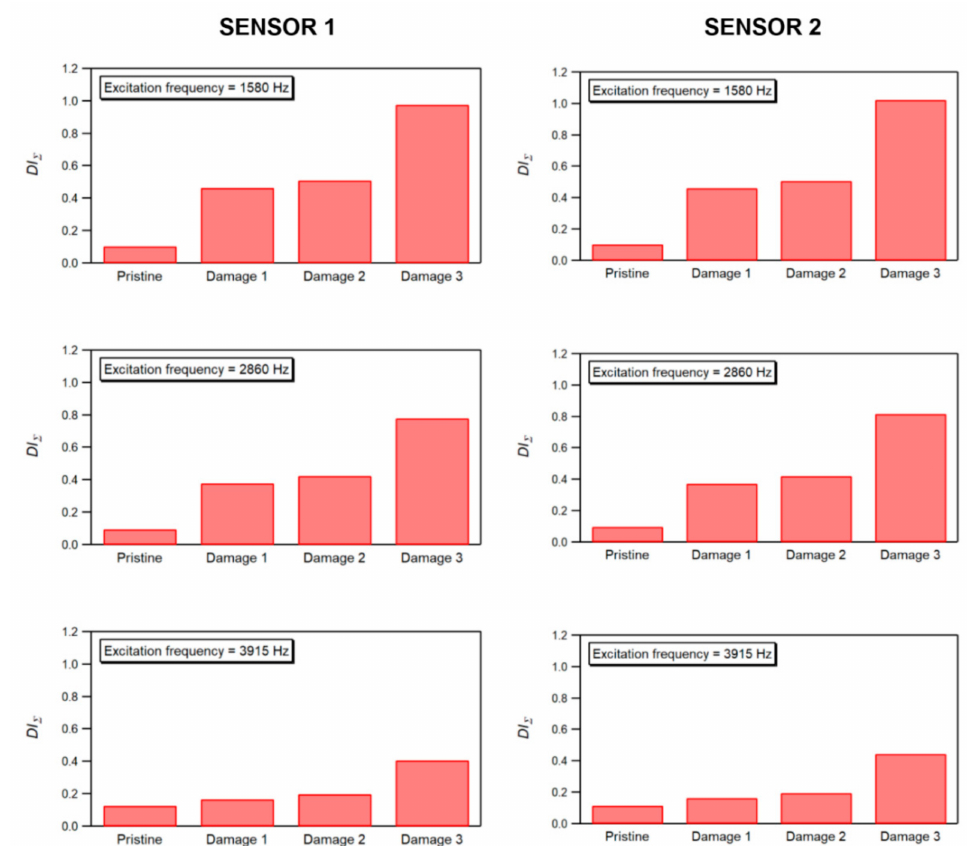
Figure 7. Harmonic excitation: values of the damage index DI S calculated for the different excitation frequencies at increasing damage